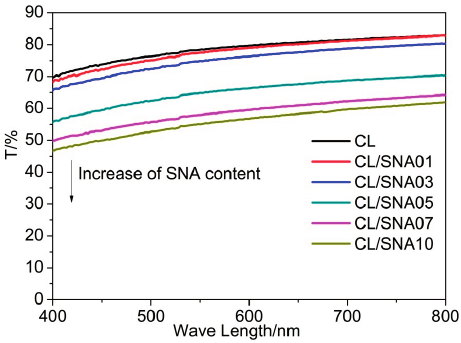
Figure 4. Transmittance of CL film and CL/SNA nanocomposite